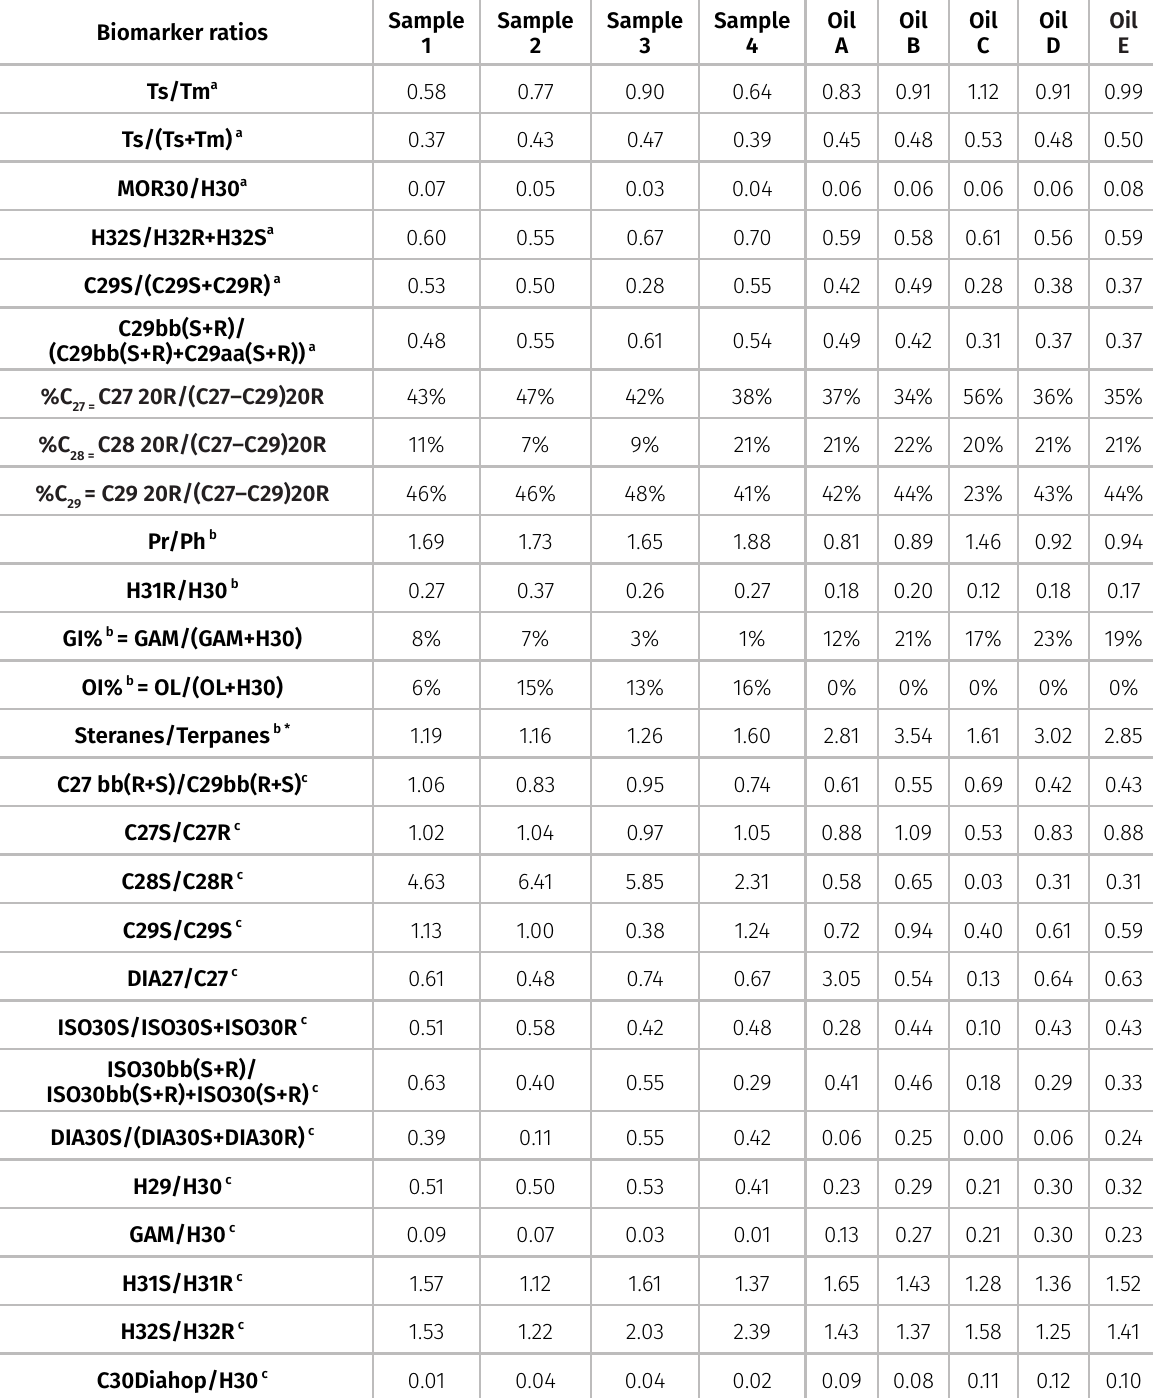
Table III. Oil sample biomarker ratios for identification of organic matter sources and depositional environments. Biomarker